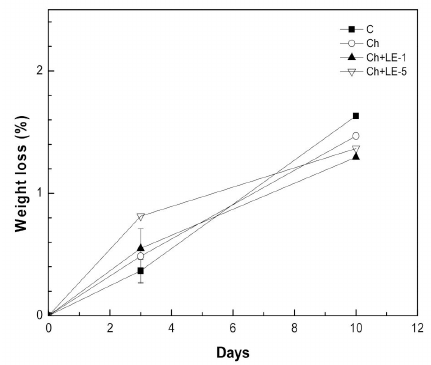
Figure 7. E ff ect of di ff erent licorice-chitosan coatings on the weight loss of strawberries stored for 10 days at 4 ◦ C: ( ) Ch (chitosan) ( (cid:78) ) Ch + LE-1 (Chitosan + 1% of licorice extract); ( (cid:96) ) Ch + LE- 5 (cid:35) (Chitosan + 5% of licorice extract; ( (cid:4) ) C = uncoated.